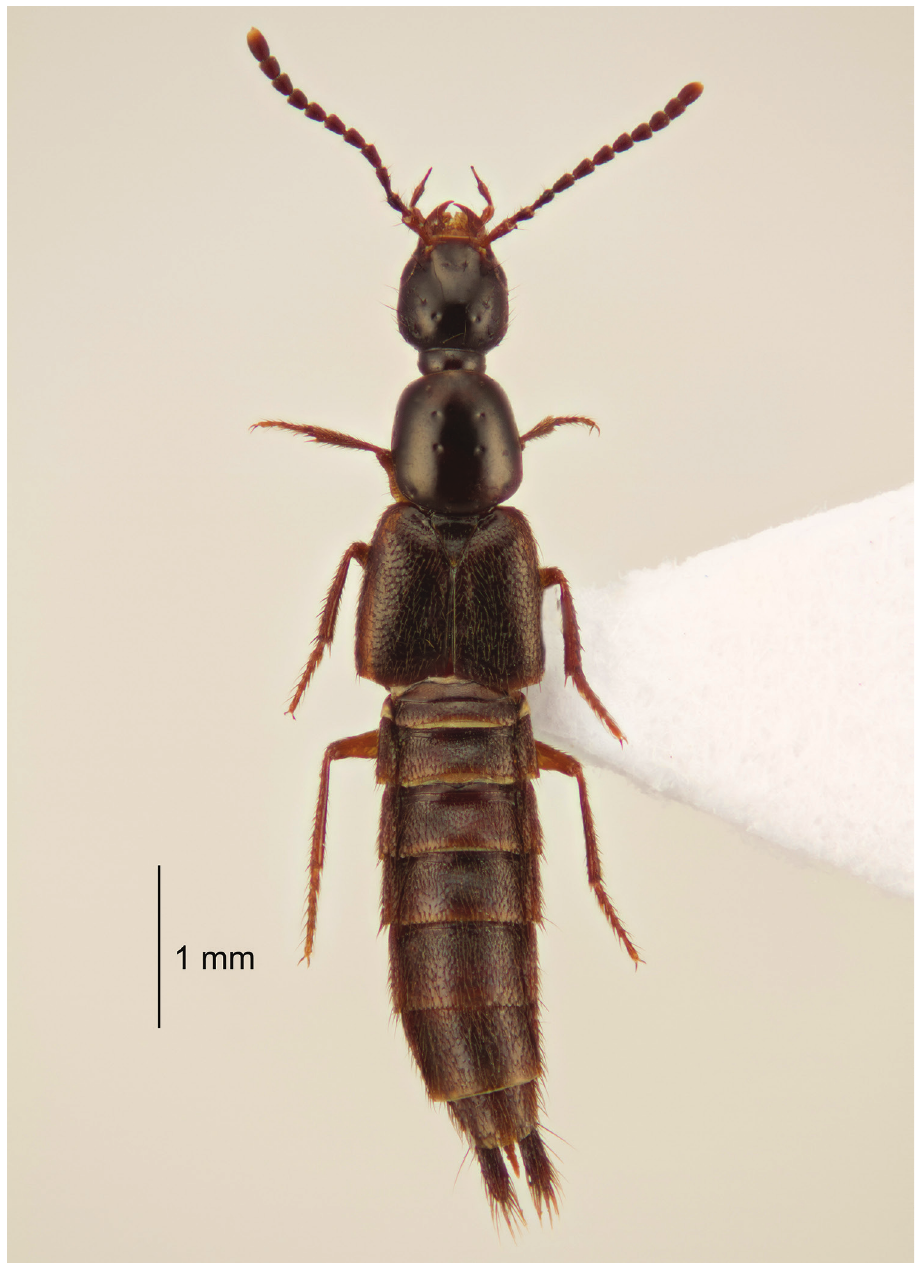
Figure 3. Habitus of Cheilocolpus olliffi Jenkins Shaw & Solodovnikov, sp.